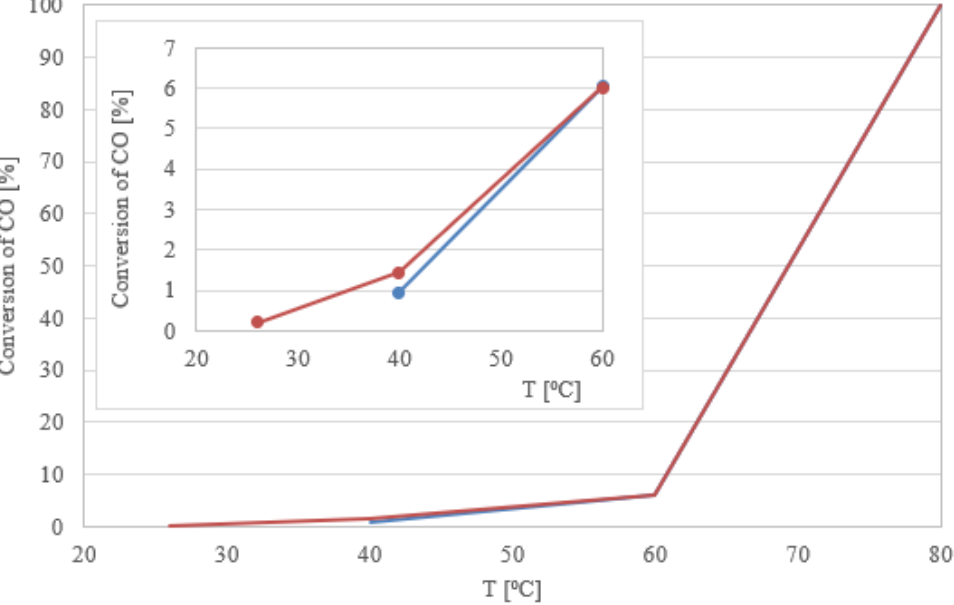
Figure 3. Catalytic activity of Pd/TiO 2 ( — ) and Pd – Zn/TiO 2 (5%-wt.Pd; Pd/Zn = 2:1) of model cata- lysts ( — ) .